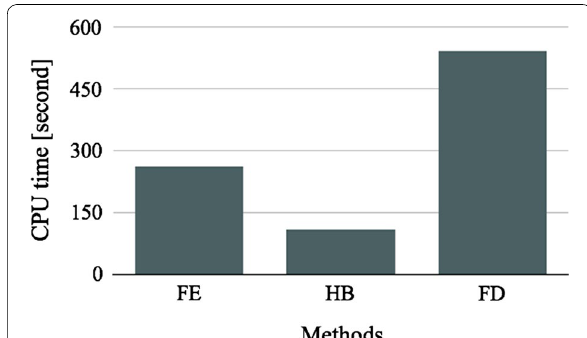
Fig. 13 The total CPU times required by the FE, HB and FD methods for the bathymetric